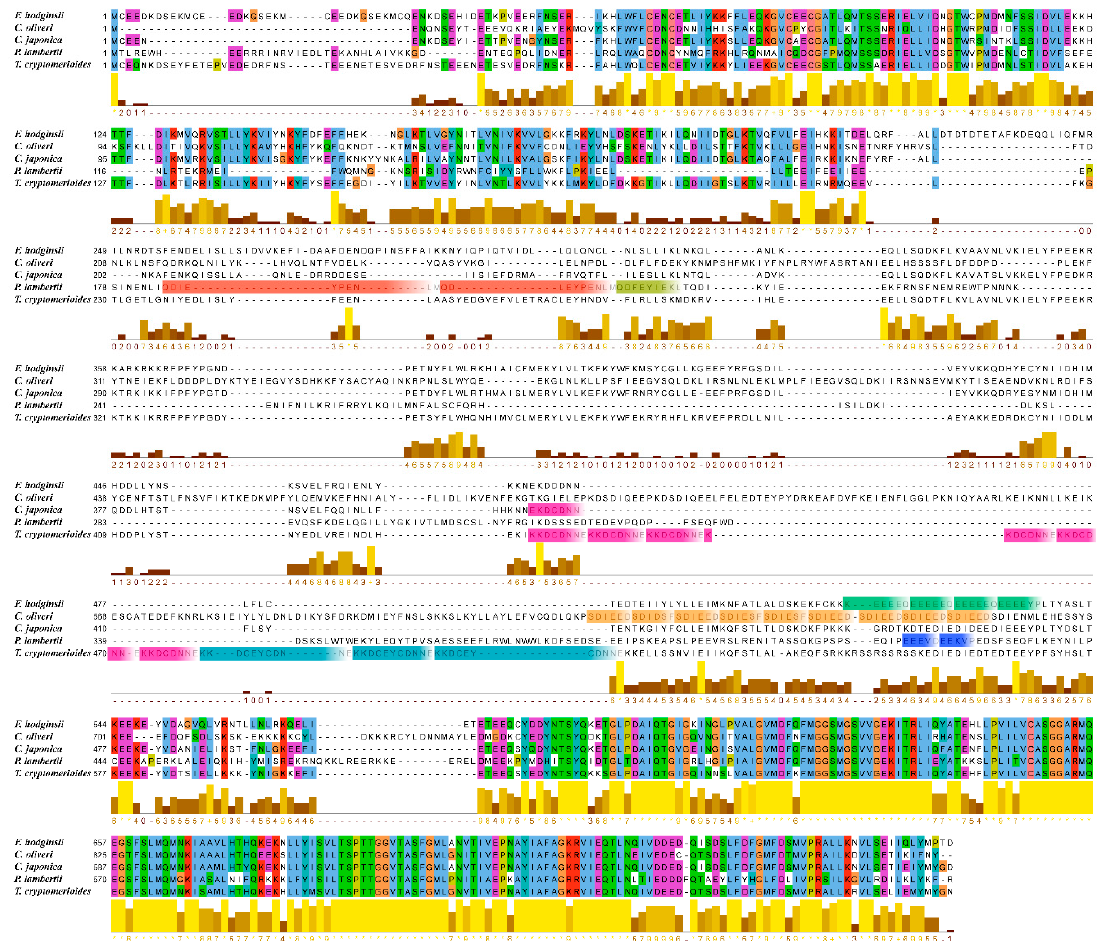
Figure 5. Comparison of accD sequences from five Cupressophyta members. Yellow histograms below each line indicate the conservation of aligned sequences. Different repetitive elements are marked with different gradient colored boxes.